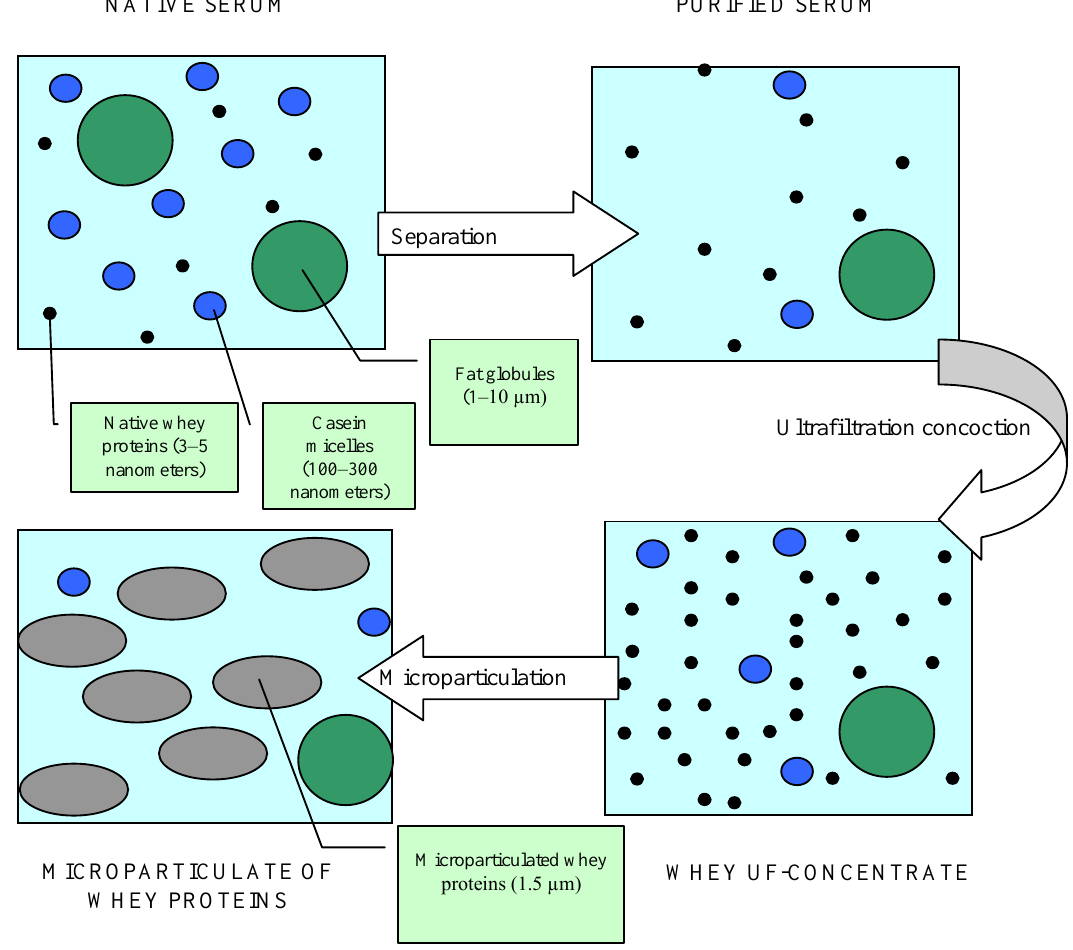
Fig. 9. Scheme of microparticulation of cheese whey proteins (according to E.I. Mel'nikova and N.A.